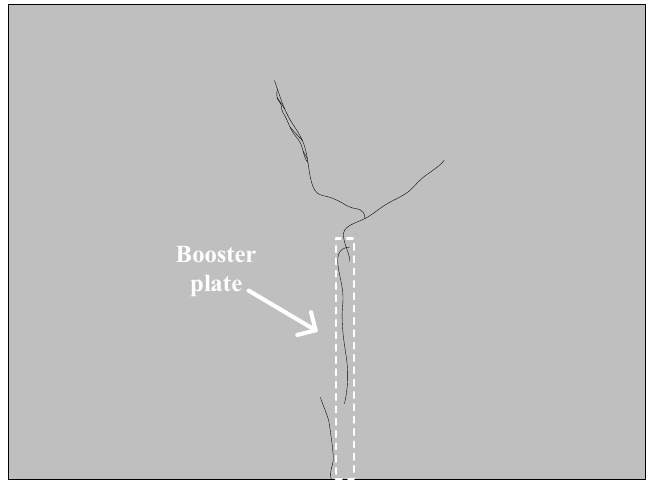
Figure 17. Schematic view of the connected cracks at the end of the air pressurisation.